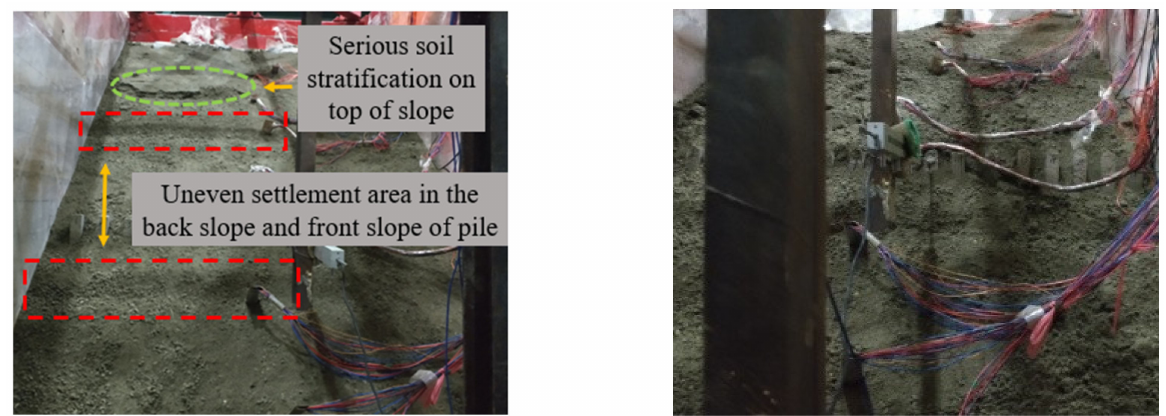
Figure 13. 0.6 g sine wave 1st ( left ) and 3rd ( right )